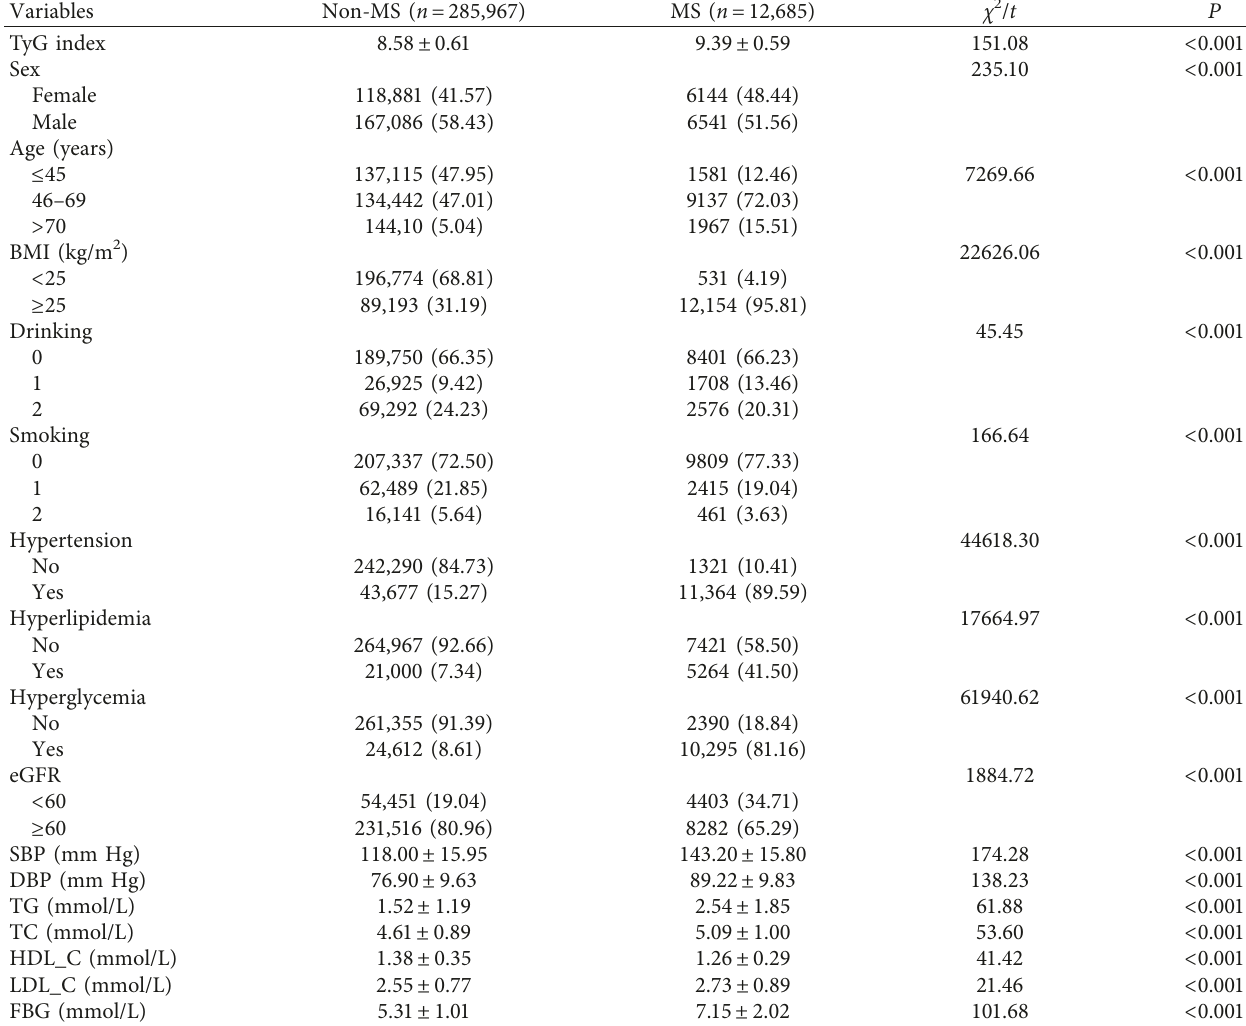
Table 3: Comparison of the demographic characteristics and biochemical indices between MS subgroups.